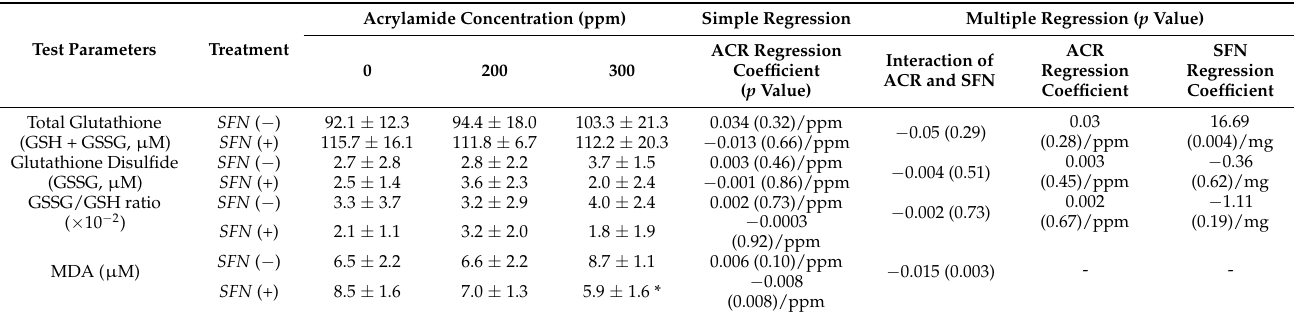
Table 5. Effects of different doses of acrylamide and sulforaphane co-treatment on the expression levels of oxidative stress markers in cerebral